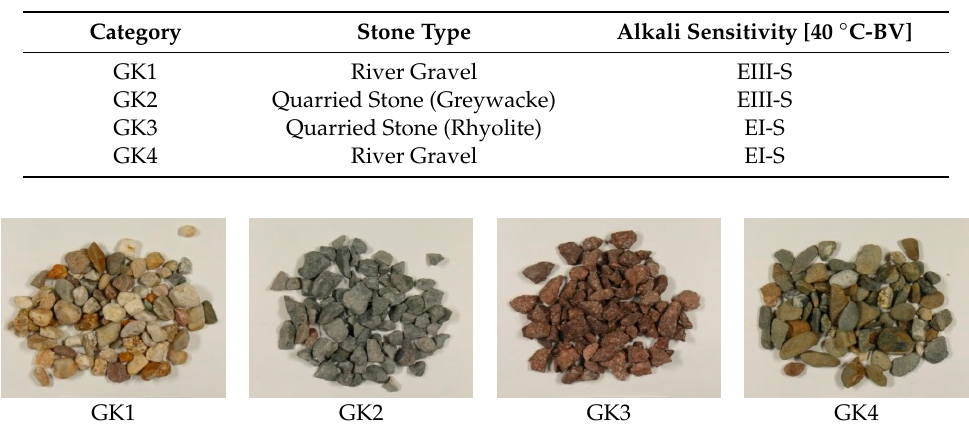
Figure 1. Photographs of typical individual grains from each of the stone categories. Table 1. Categories of stone selected for cracking analysis.